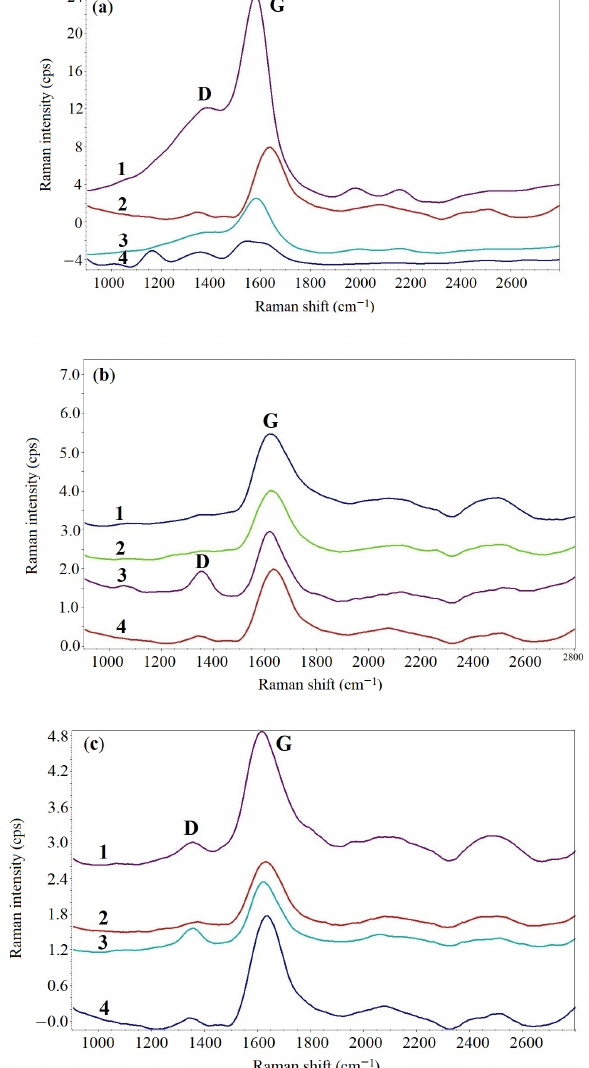
Figure 4. Raman spectra of nanoparticles in aqueous dispersions: ( a ) 1. ShC-Ag nanoparticles un- derwent ns irradiation; 2. Initial dispersion of ShC nanoparticles; 3. ShC -Ag after fs pulse; 4. ShC-Ag irradiated CW; ( b ) ShC -Au nanoparticles irradiated: 1. ns; 2. fs; 3. CW; 4. Initial dispersion of ShC nanoparticles. Spectra a 2—the signal intensities increased four-fold. (c ) Raman spectra of aqueous dispersions of ShC nanoparticles under laser irradiation of various durations: 1—ns, 2—fs, 3—CW, 4—original dispersion (reference). G and D are the typical Raman spectrum bands of car- bon materials.